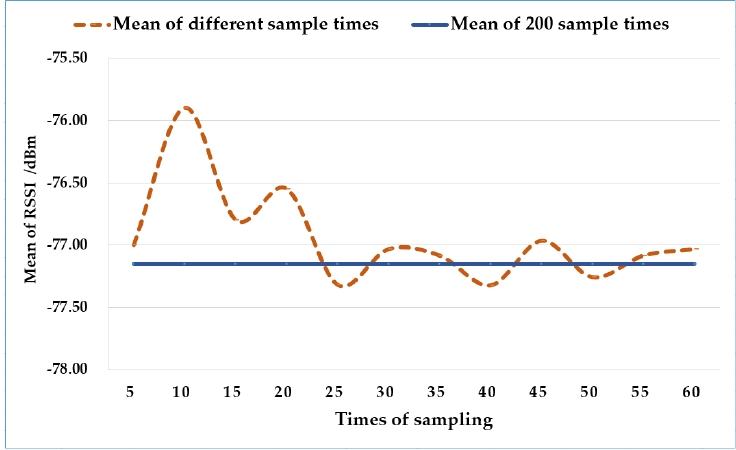
Figure 6. Verification of optimum sampling times.